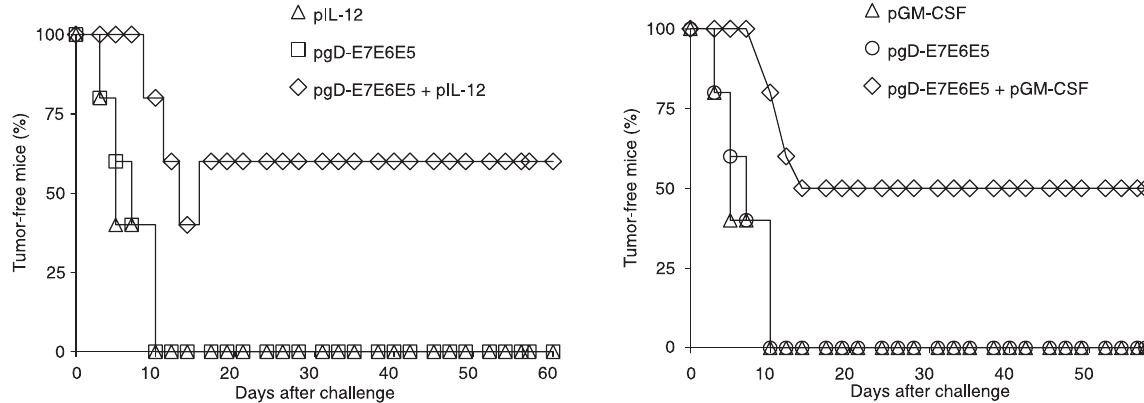
Figure 3. Co-administration of pgD-E7E6E5 and IL-12 or GM-CSF-encoding plasmids confers enhanced anti-tumor therapeutic ef- fects. Mice were immunized id with a single dose of pgD-E7E6E5 admixed with pIL-12 (A) or pGM-CSF (B) vectors (1 µg/dose of each vector). Mice immunized with a single dose of the pgD-E7E6E5, pIL-12 or pGM-CSF are also indicated. The vaccines were adminis- tered 8 h after inoculation of 5 x 10 5 TC-1 cells. IL-12 = interleukin-12; GM-CSF = granulocyte-macrophage colony-stimulating